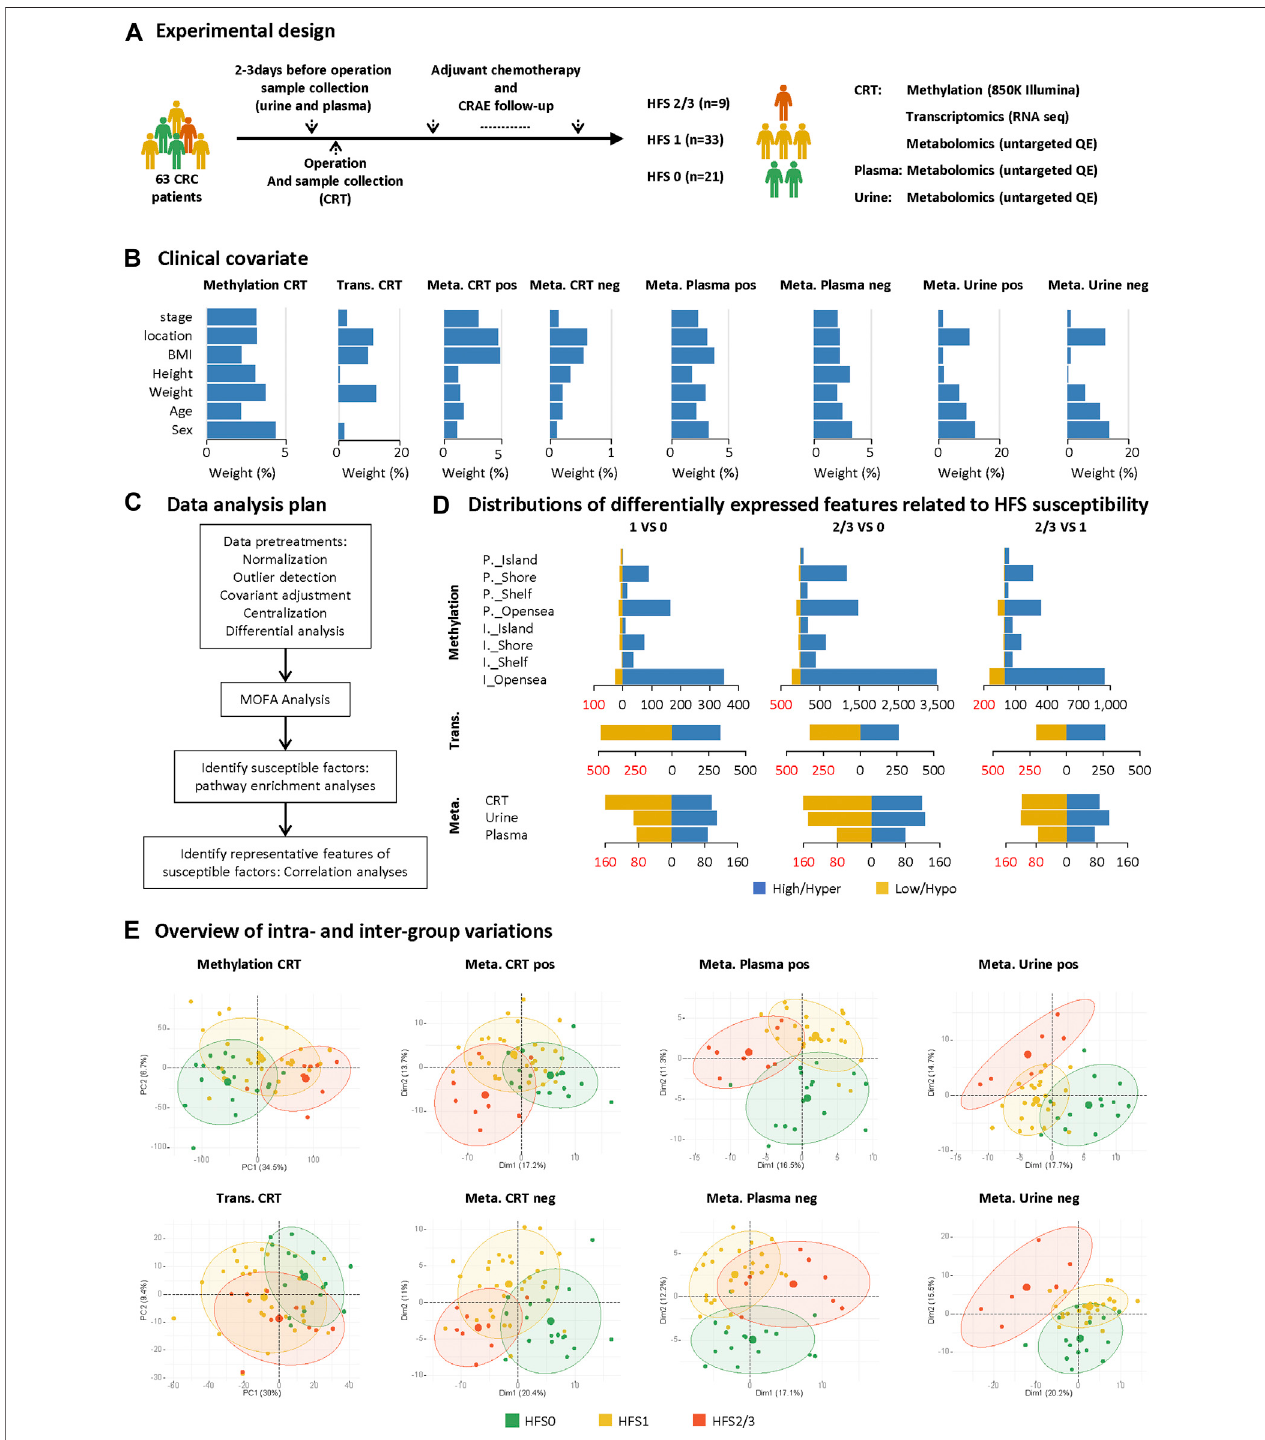
FIGURE 1 | Study design and differential analyses on multi-omics datasets. (A) Sample collection and the experimental design. (B) The weighted average proportion varianceofeach clinicalcovariateeffectin each omicsdataset(CRT methylation,CRTtranscriptome,CRT/plasma/urinemetabolome). (C) Dataanalysisplan. (D) Distributionsof differentiallyexpressedfeatures(DEFs)relatedtoHFSsusceptibilityineachomicsdataset. (E) Overviewofintra-andinter-groupvariations.Aprincipalcomponentsanalysis(PCA) plotwasgeneratedusingDEFsfromeachomicsdataset.Themetabolomedatawereacquiredunderpositive(pos)andnegative(neg)modesandareplottedseparately.The circleof each group represents the 75% con fi dence interval. Abbreviations: CRC, colorectalcancer; CRAE, chemotherapy-related adverse event; CRT, normal colorectal tissue; DEF, differentially expressed feature; Meta, metabolome; Trans, transcriptome; P._Island, promoter-island region; P._Shore, promoter-shore region; P._Shelf, promoter-shelf region; P._Opensea, promoter-opensea region. Here, we focused on DMPs mapped to a speci fi c gene, and thus DMPs in intergenic regions are not displayed here.